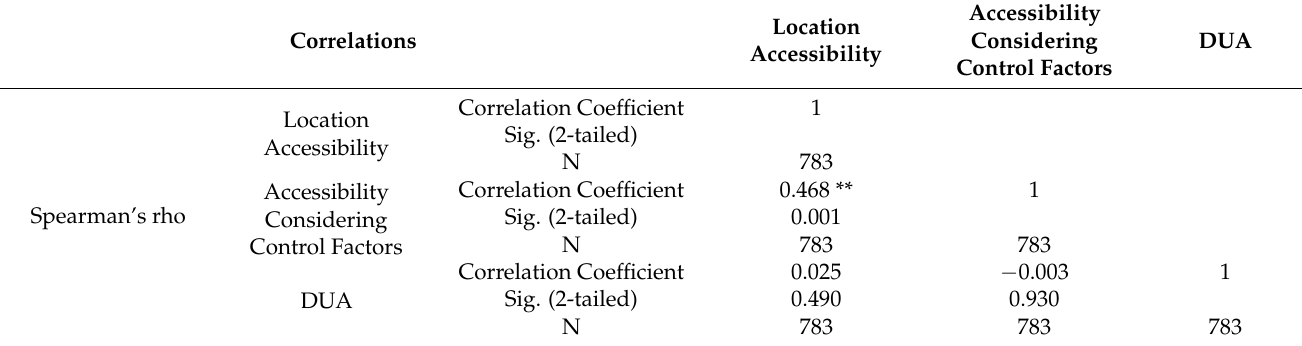
Table 6. Nonlinear